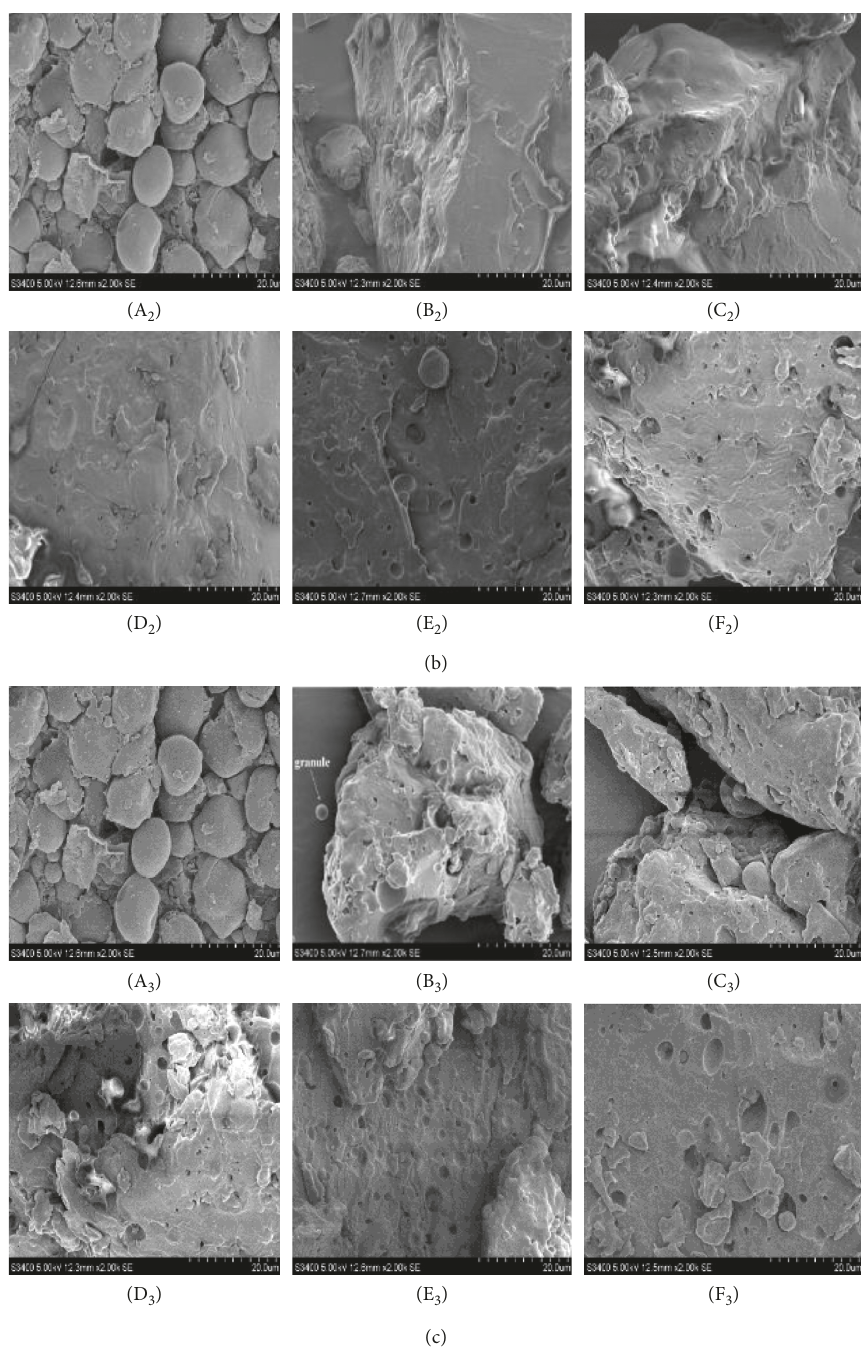
Figure 6: Scanning electron micrographs of adlay flour treated by extrusion at different extrusion conditions (2000 × ). (a) Barrel tem- perature (A1-F1): native, 80, 100, 120, 140, and 160 ° C; (b) moisture content (A2-F2): native, 19, 21, 23, 25, and 27g (100g) − 1 wb; (c) screw speed (A3-F3): native, 170, 210, 250, 290, and 330